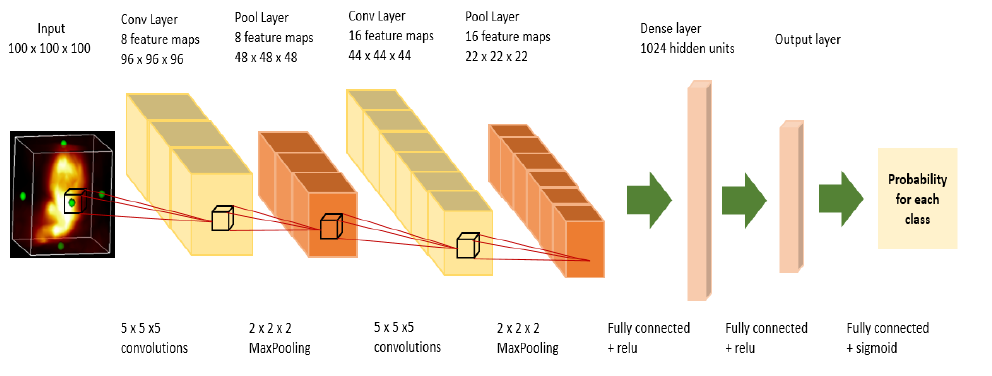
Figure 7. 3D RPET-NET architecture composed by two 3D convolutional layers followed by 3D pooling layers and two dense layers.